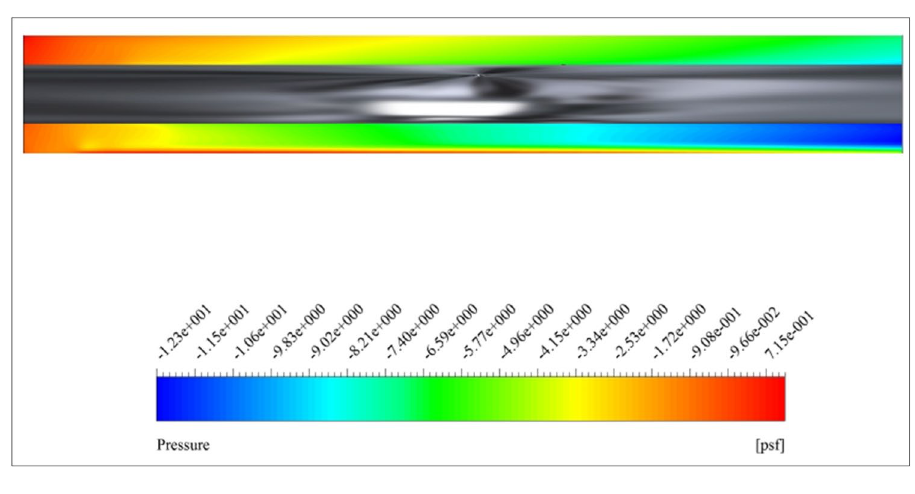
Fig. 12 Flow lines colored based on cuttings volume frac-